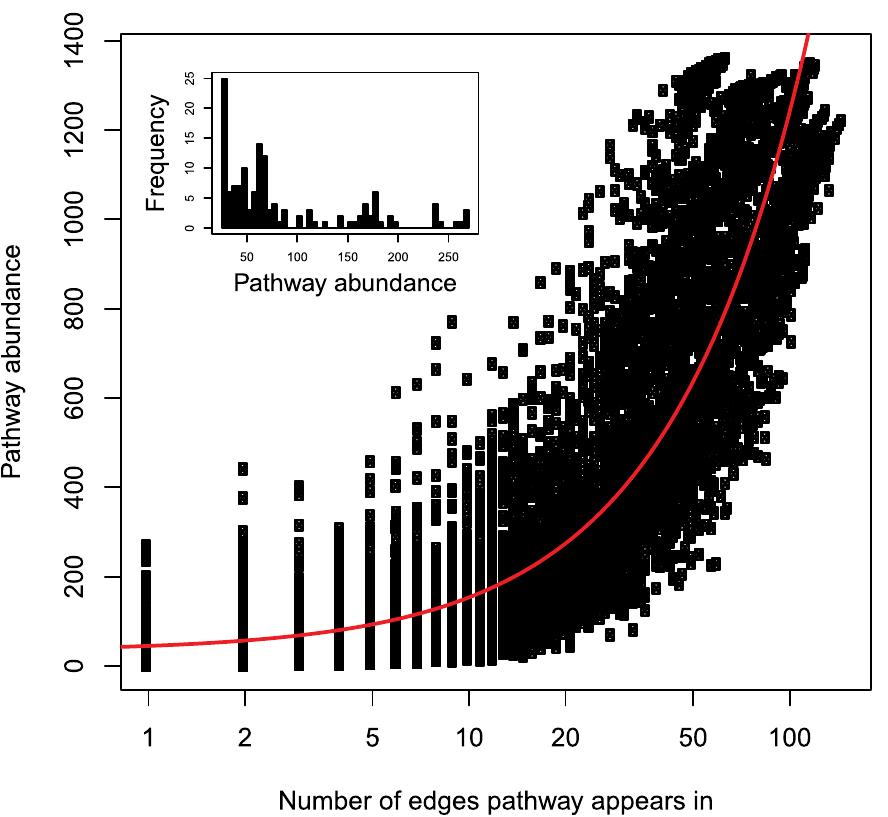
Fig 7. Pathway abundance as a function of the number of edges pathway appears in for a given sample. Inset is a histogram for abundance at the edge richness of 1 (i.e. the abundance of pathways with the lowest redundancy). Abundance and edge richness are linearly correlated (red line; R 2 = 0.78, df = 11,623, p (cid:4)